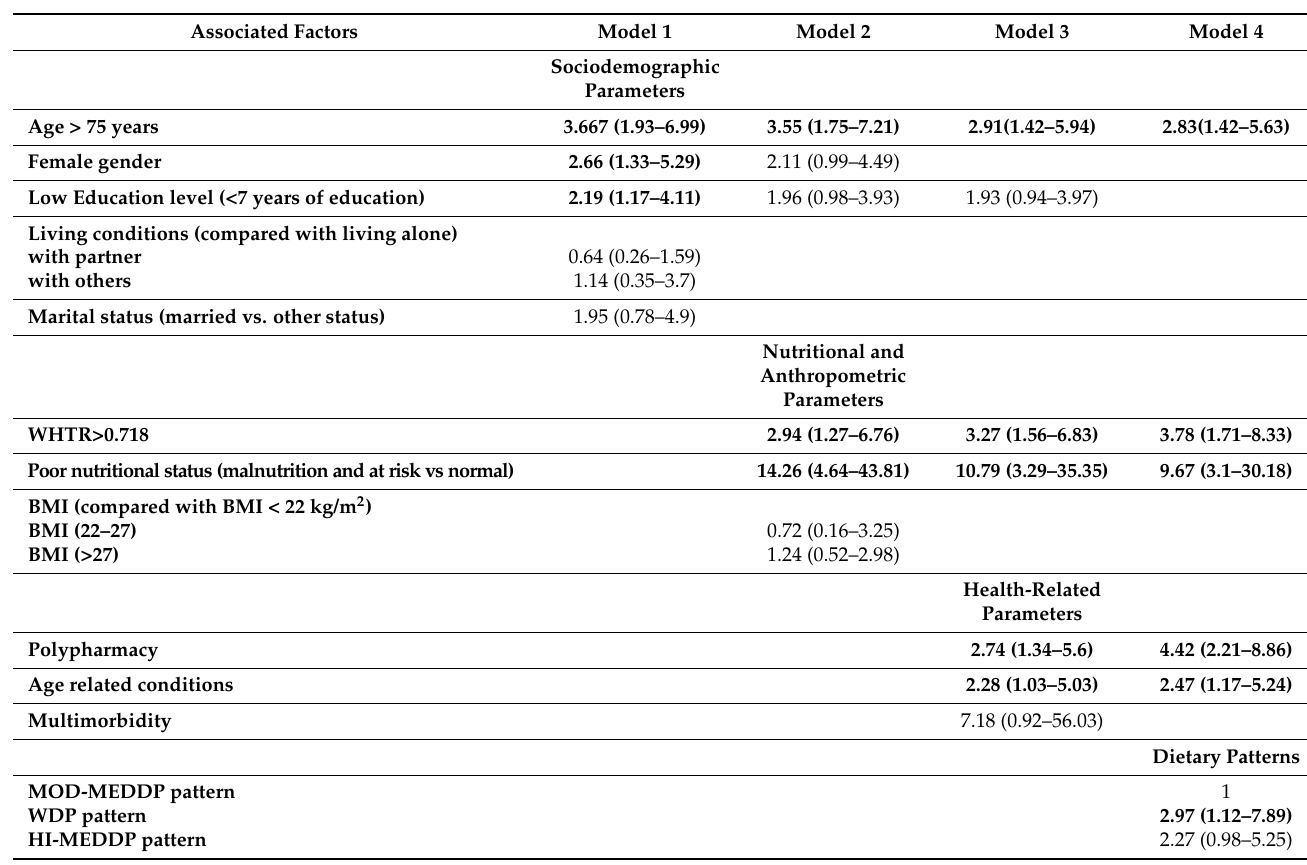
Table 5. Binary logistic regression models of frail vs. non-frail for the total sample.